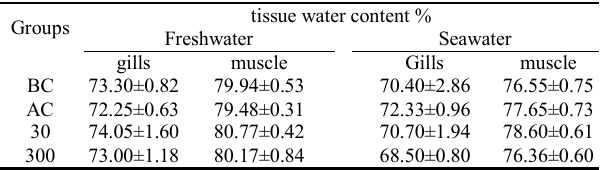
Table 4. Tissue water content (%) in fat snook Centropomus parallelus , under control conditions (BC: basal control; AC: aquarium control) or submitted to the essential oil from old leaves of Nectandra megapotamica (30 and 300 µL L -1 ). Data presented as means ± SEM ( n = 6). No significant difference between groups was observed (P> 0.05).